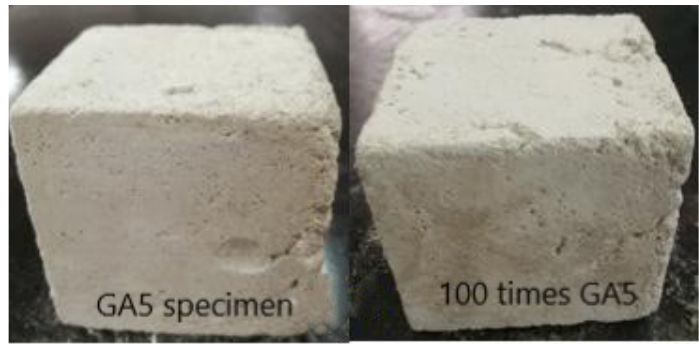
Figure 11. GS1 geopolymer and after 100 times test GS1 geopolymer. Figure 9. GA1 geopolymer and after 100 times test GA1 geopolymer.